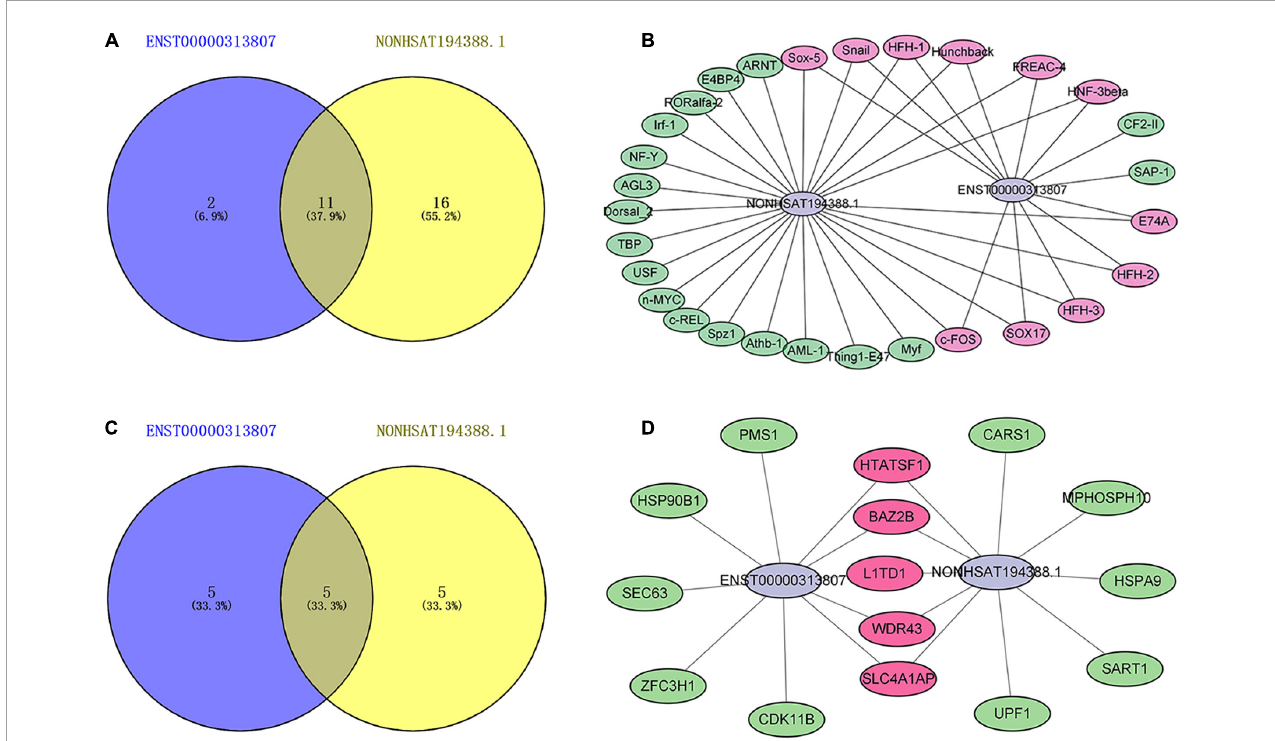
FIGURE10 Maps of lncRNAs binding to upstream transcription factors (TFs) and downstream binding proteins. (A) A Venn diagram of TFs binding to ENST00000313807 and NON-HSAT194388.1. The blue part shows the TFs binding to ENST00000313807. The yellow part shows the TFs binding to NON-HSAT194388.1, and the middle part represents the overlapping TFs of the two groups. (B) Binding map of lncRNAs and upstream TFs. The green part shows the TFs binding to ENST00000313807 or NON-HSAT194388.1. The purple part represents the overlapping TFs of the two groups. (C) A Venn diagram of proteins binding to ENST00000313807 and NON-HSAT194388.1. The blue part shows the proteins binding to ENST00000313807. The yellow part shows the proteins binding to NON-HSAT194388.1, and the middle part represents the overlapping proteins of the two groups. (D) Binding map of lncRNAs and downstream proteins. The green part shows the proteins binding to ENST00000313807 or NON-HSAT194388.1. The purple part represents the overlapping proteins of the two groups.